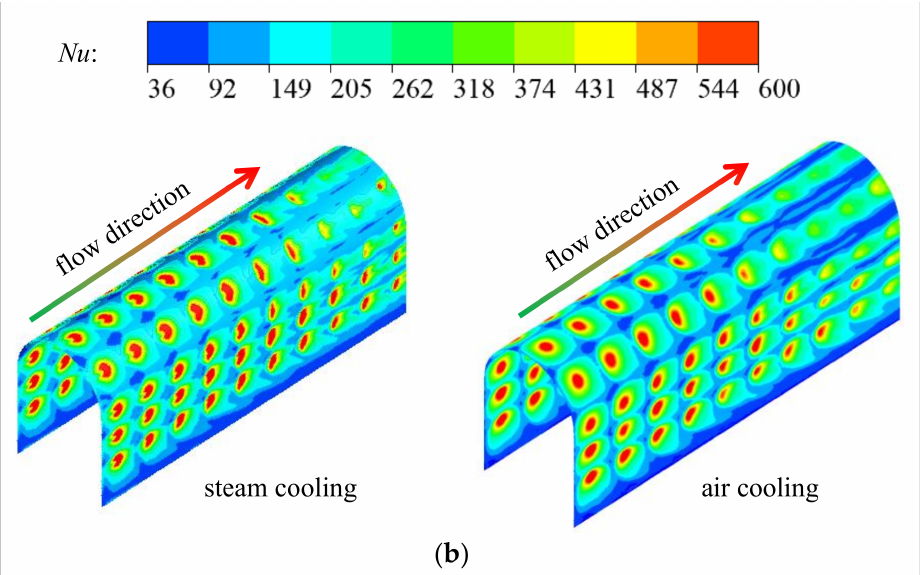
Figure 13. Distributions of flow field and heat transfer under steam cooling and air cooling: ( a ) flow field distributions; ( b ) heat transfer